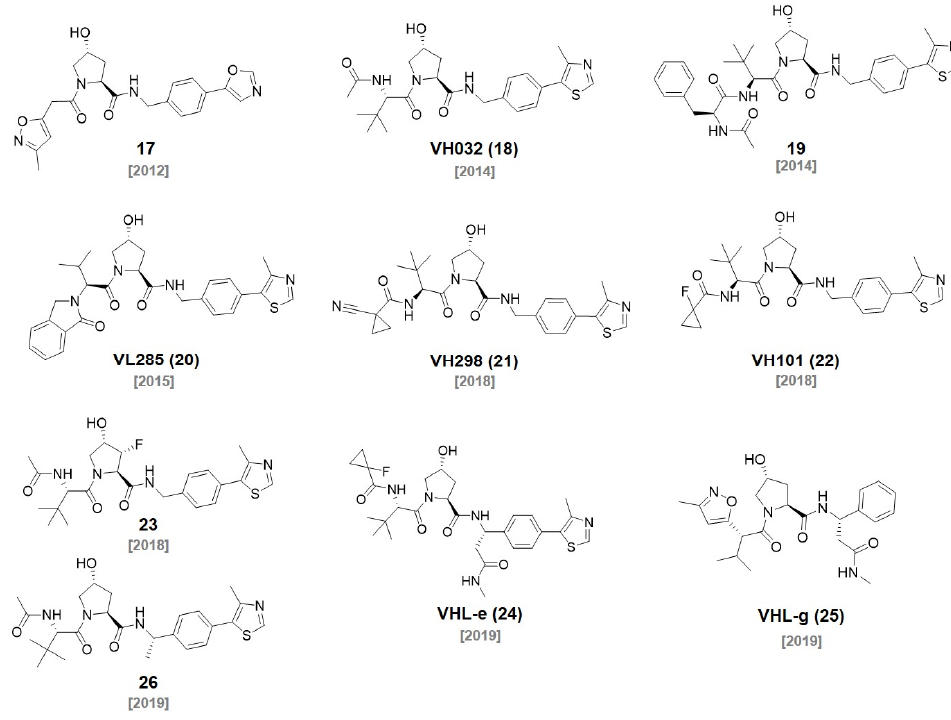
Figure 4. Chemical structures of reported VHL ligands during the last decade.